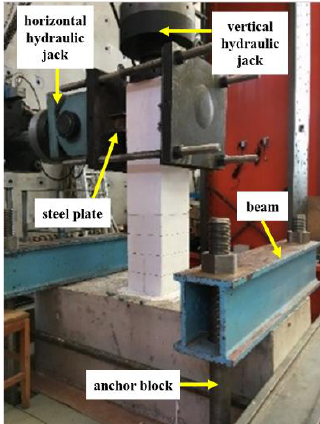
Figure 14. The specimen and the testing apparatus.